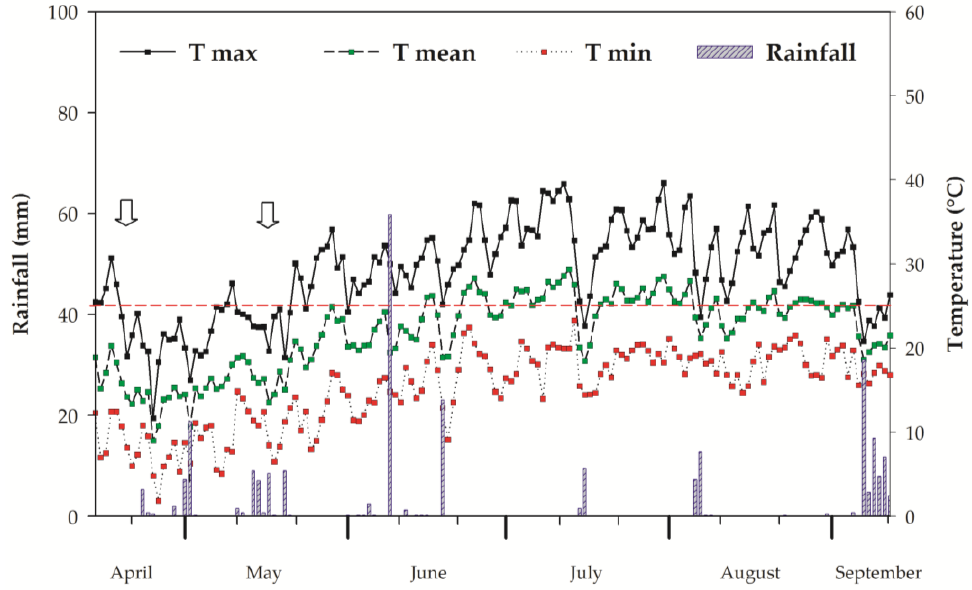
Figure 1. Daily maximum (T max), mean (T mean), and minimum (T min) temperatures and rainfall during the two experimental trials. The arrows represent the early transplant of 14 April and the late transplant of 19 May. The red horizontal line indicates the temperature of 25